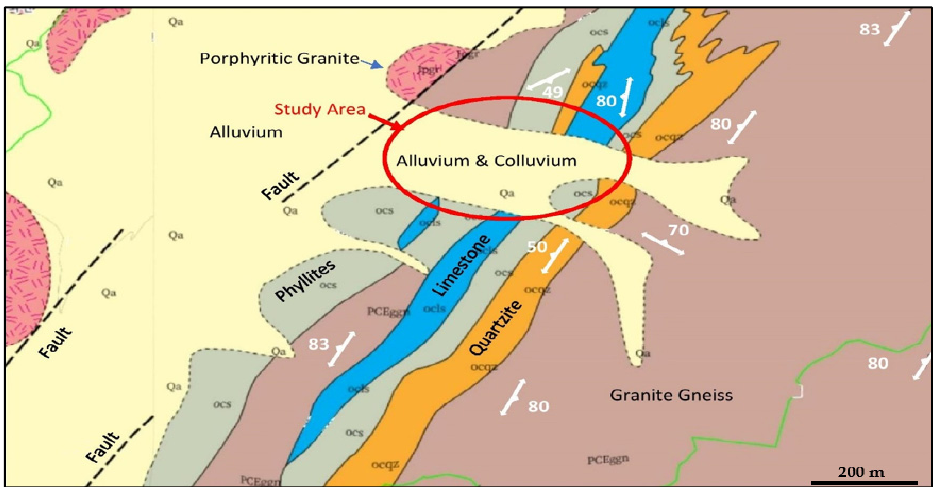
Figure 11. Site geological map of the study area.